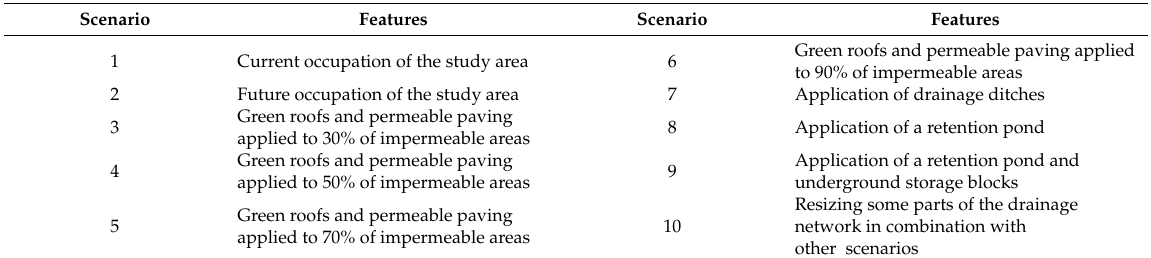
Table 4. Summary of simulated scenarios.